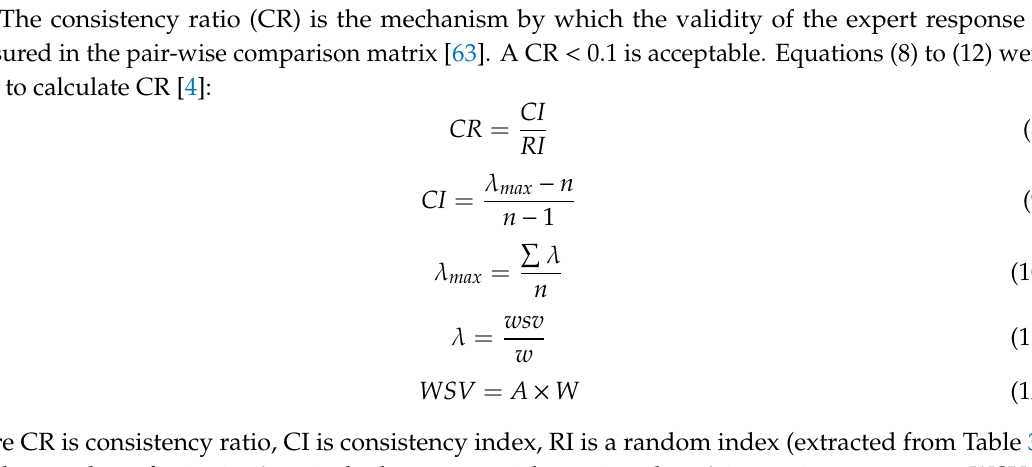
Table 2. Saaty’s linguistic scales in the analytical hierarchy process (AHP) [64]. Preference Factor Degree of Preference 1 Equally 3 Moderately 5 Strongly 7 Very strongly 9 Extremely 2, 4, 6, and 8 Intermediate between 2 adjacent judgments